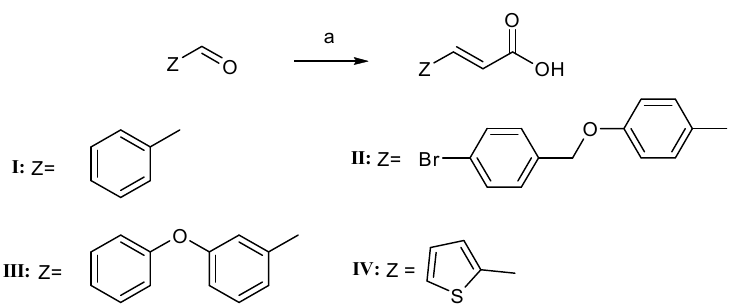
Scheme 1. Synthesis of cinnamic